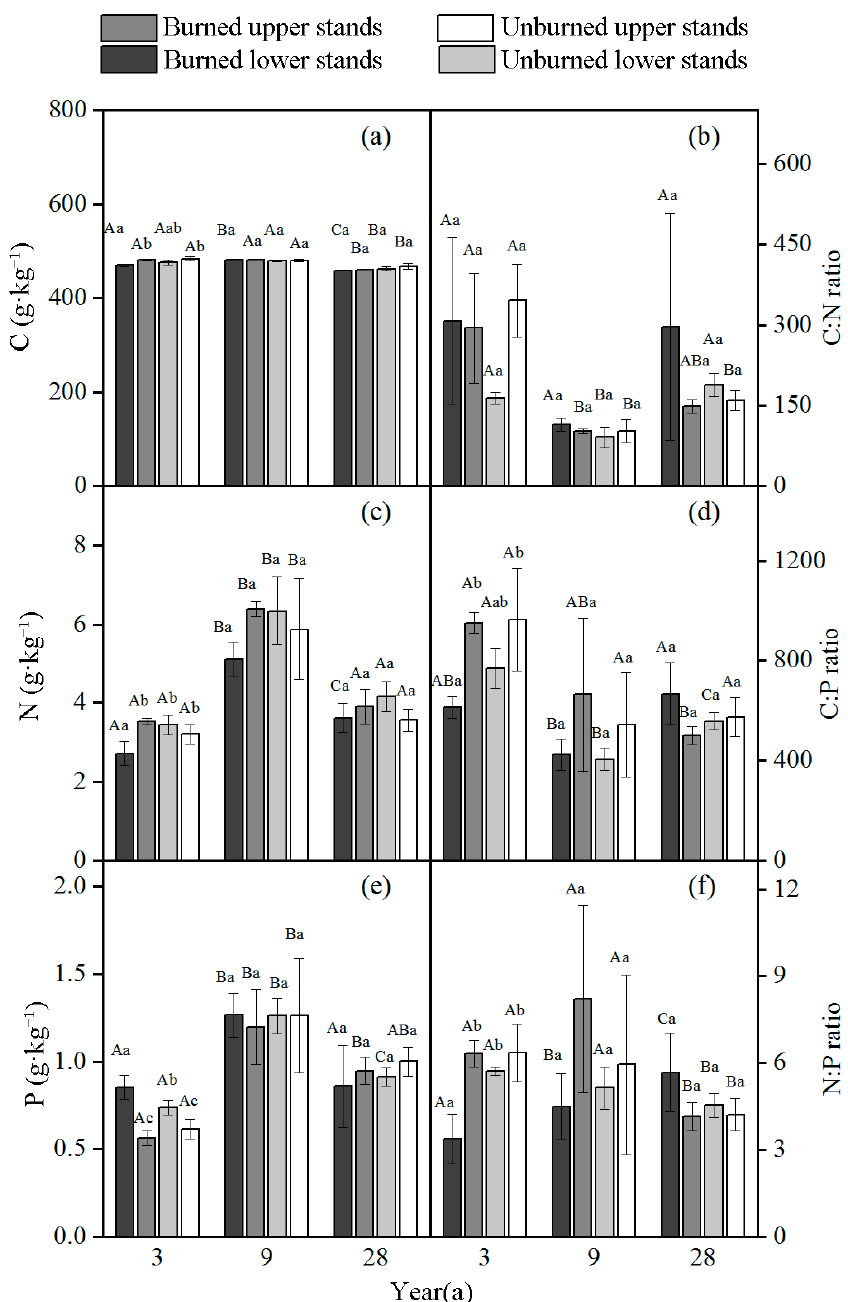
Figure 4. Carbon (C), nitrogen (N), and phosphorous (P) contents and stoichiometric ratios of leaf litter in stands of different years after fire disturbance in the Larix gmelinii forest ( n = 3). Note: The data are the average annual value ± standard error. Capital letters represent differences between groups, and small letters represent differences within groups. ( a ) indicates the change of C concentration of litter in different layers under different burning years; ( b ) indicates the change of C:N of litter in different layers under different burning years; ( c ) indicates the change of N concentration of litter in different layers under different burning years; ( d ) indicates the change of C:P of litter in different layers under different burning years; ( e ) Indicates the change of P concentration in different layers of litter under different burning years; ( f ) indicates the change of N:P in different layers of litter under different burning